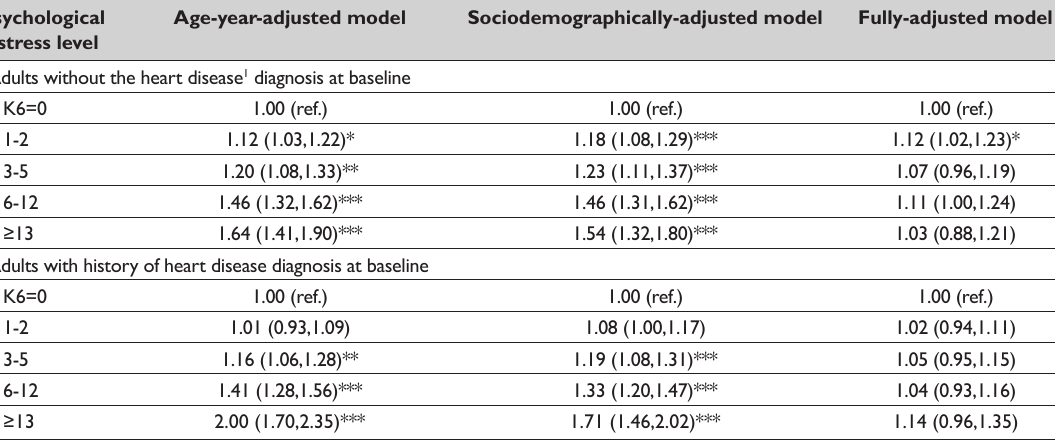
Table 5: Age-year-adjusted and covariate-adjusted hazard ratios (HRs) for heart disease mortality among adults aged ≥18 years with and without a history of heart disease diagnosis at baseline, 1997-2014 Psychological Age-year-adjusted model Sociodemographically-adjusted model Fully-adjusted distress level